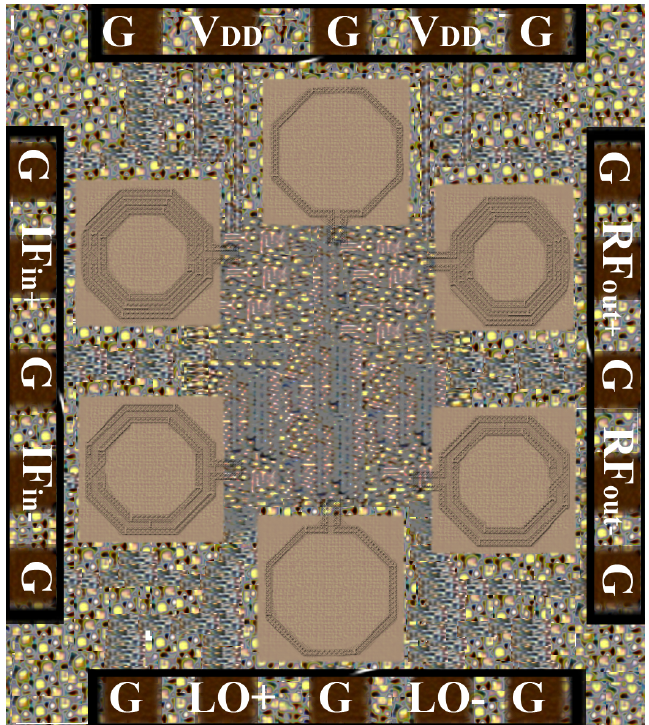
Figure 10. Micro-photograph of designed mixer’s